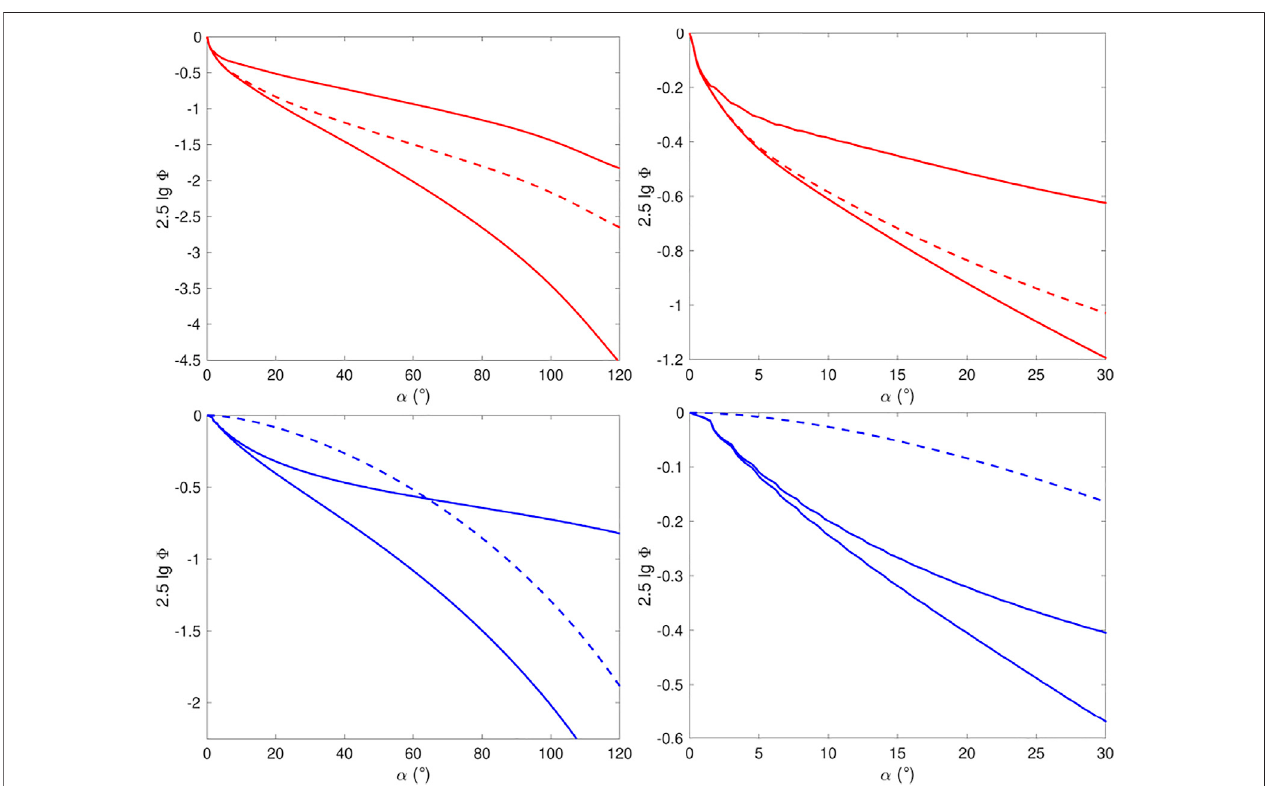
FIGURE 1 | Phase functions and their ratios on the magnitude scale. The red curves (top left and right) correspond to the lunar phase function Φ (lowermost solid line),theratio Φ / Φ LS (middledashedline),andtheratio Φ / Φ PM (uppermostsolidline;see Eq.7 ).Thebluecurves(bottom leftandright)denote Φ PM (lowermostsolidline), Φ α =120 ° ,middledashedline),and Φ Φ α =120 ° ,uppermostsolidline).Theraggednessatsmallphaseanglesisanartefactderivingfromtheinterpolation LS (at PM / LS (at of Φ PM